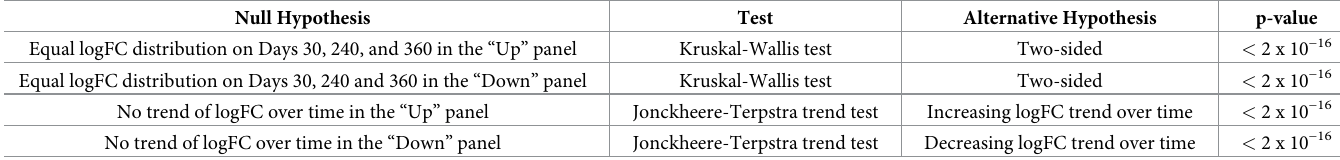
Table 4. Test results for means and trends of trajectories of the 345 late onset genes. Null Hypothesis Test Alternative Hypothesis p-value Equal logFC distribution on Days 30, 240, and 360 in the “Up” panel Kruskal-Wallis test Two-sided < 2 x 10 − 16 Equal logFC distribution on Days 30, 240 and 360 in the “Down” panel Kruskal-Wallis test Two-sided < 2 x 10 − 16 No trend of logFC over time in the “Up” panel Jonckheere-Terpstra trend test Increasing logFC trend over time < 2 x 10 − 16 No trend of logFC over time in the “Down” panel Jonckheere-Terpstra trend test Decreasing logFC trend over time < 2 x 10 − 16 The mean/median of trajectories were assessed using a Kruskal-Wallis test. The trajectory trends were evaluated using a Jonckheere-Terpstra